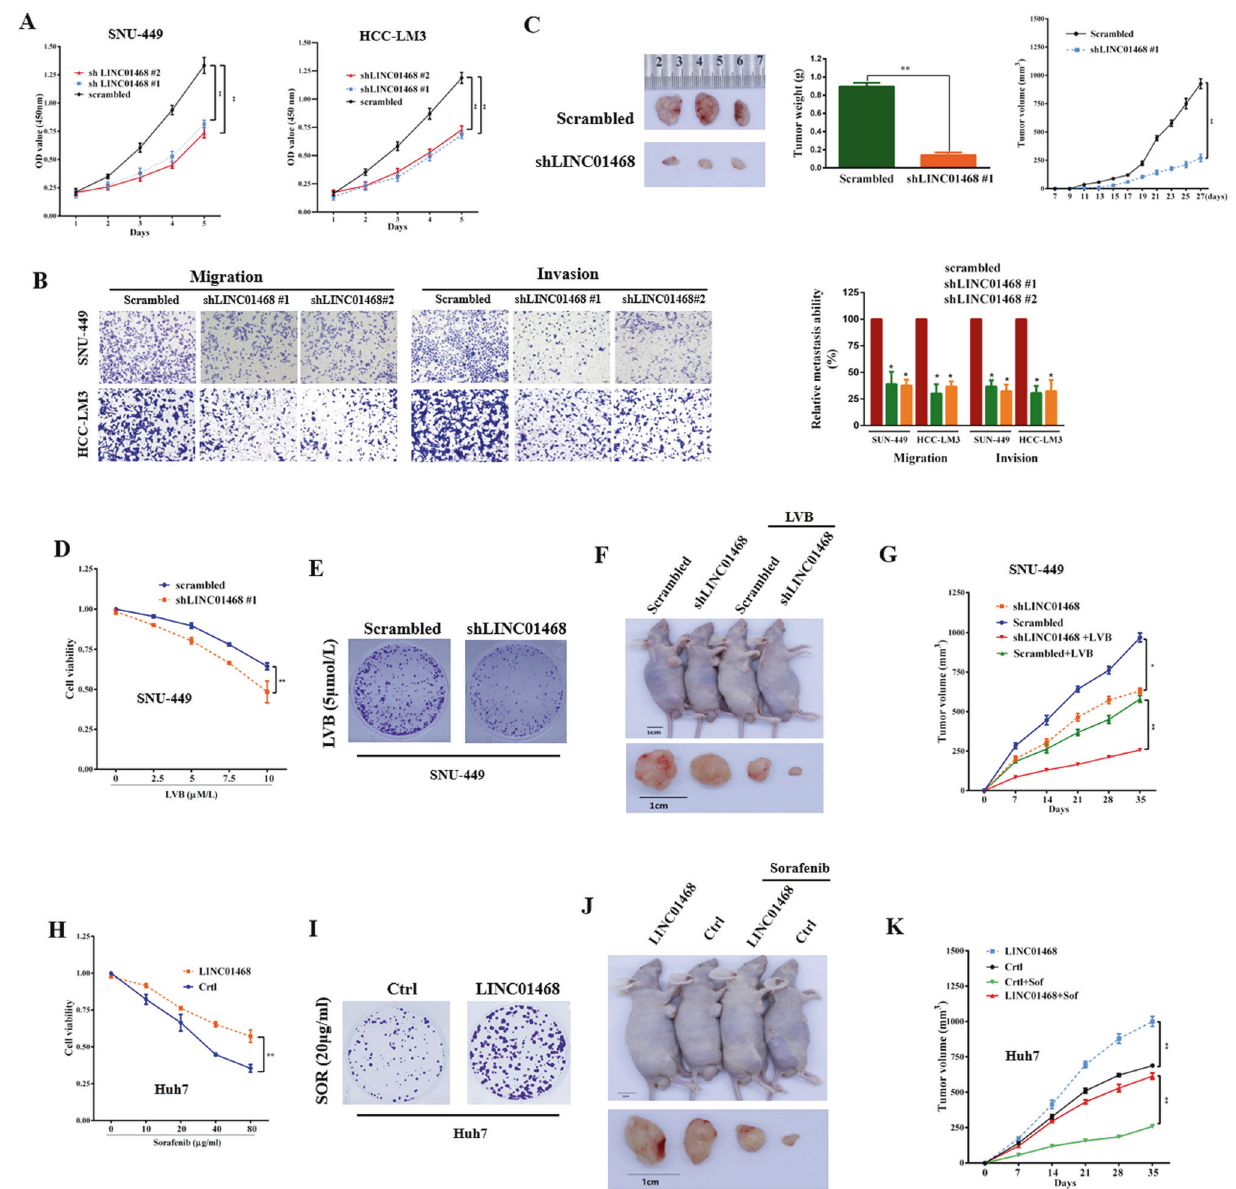
Fig. 2 LINC01468 silencing suppresses the chemoresistance of HCC cells and inhibits HCC tumorigenesis by lipid metabolism. A CCK8 assays in SNU-449 and HCC-LM3 cells transfected with or without shLINC01468. B Representative images (left panel) and number (right panel) of migratory or invasive cells transfected with the scrambled control or shLINC01468. C Representative images (left panel), weight (middle panel), and growth (right panel) of xenografts derived from HCC cells stably transfected with the scrambled control or shLINC01468. D The viability of SNU-449 cells transfected with shLINC01468 or scrambled control in the presence of different concentrations of lenvatinib (LVB) treatment was examined by the CCK8 assay. E A representative image of colony formation of SNU-449 cells transfected with shLINC01468 or scrambled control after treatment with 5 μ M LVB. F , G Representative tumor images ( F ) and tumor growth curves ( G ) of xenografts derived from SNU-449 cells stably transfected with shLINC01468 or scrambled control in the presence or absence of intraperitoneal LVB injections. The right fl anks of all the mice were subcutaneously injected with 5 × 10 6 cells. The tumors were collected after 4 weeks. H Viability of Huh7 cells transfected with LINC01468 or Ctrl in the presence of different concentrations of sorafenib was examined by the CCK8 assay. I A representative image of colony formation of Huh7 cells transfected with LINC01468 or Ctrl after treatment with 20 μ g/mL of sorafenib. J , K Representative tumor images ( J ) and tumor growth curves ( K ) of xenografts derived from Huh7 cells stably transfected with LINC01468 or control in the presence or absence of intraperitoneal injections of 20 μ g/mL sorafenib. The right fl anks of the mice were subcutaneously injected with 5 × 10 6 cells. The tumors were collected after 4 weeks. The data represent the means ± S. D (* P < 0.05; ** P < 0.01). decreased the levels of intracellular TG and TC (Fig. 3I). LINC01468 overexpression (Fig. 3G). We also evaluated the LINC01468 silencing had signi fi cantly decreased levels of effect of LINC01468 on the lipid content in HCC. As shown neutral lipid in vivo (Fig. 3J). To examine the functional in Fig. 3H, LINC01468 silencing signi fi cantly decreased the consequences of LINC01468 in vivo, we established orthotopic level of neutral lipid staining by oil red O. These results were xenografts derived from control- or LINC01468-expressing further corroborated by the fi ndings for the cellular lipid HCCs. Tumors overexpressing LINC01468 grew faster than content, indicating that LINC01468 silencing signi fi cantly Cell Death Discovery (2022)